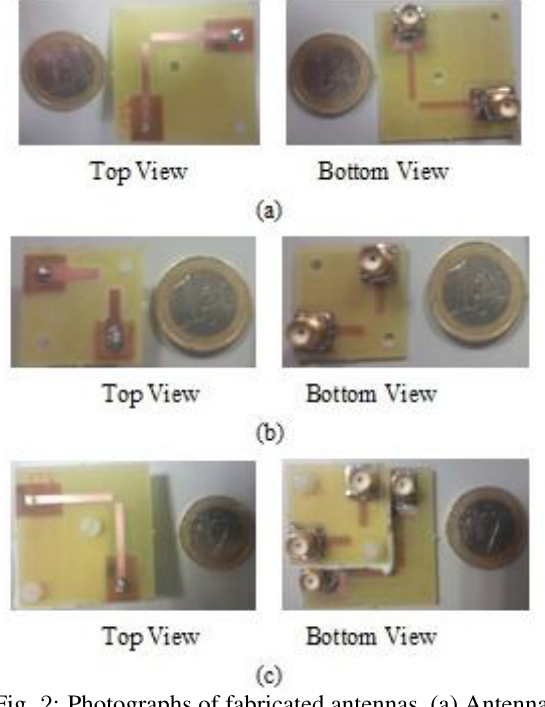
Fig. 2 : Photographs of fabricated antennas, (a) Antenna-1, (b) Antenna-2, (c) Combined